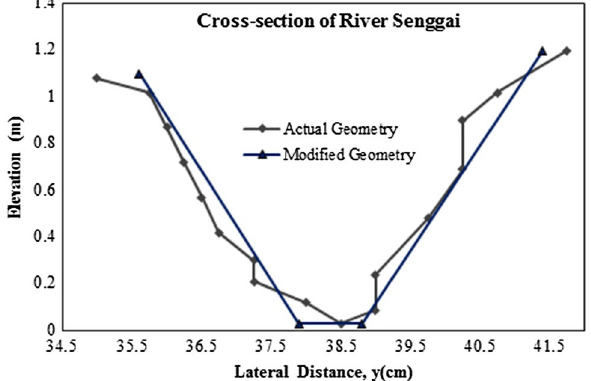
Fig. 18 Actual cross section of river Senggai